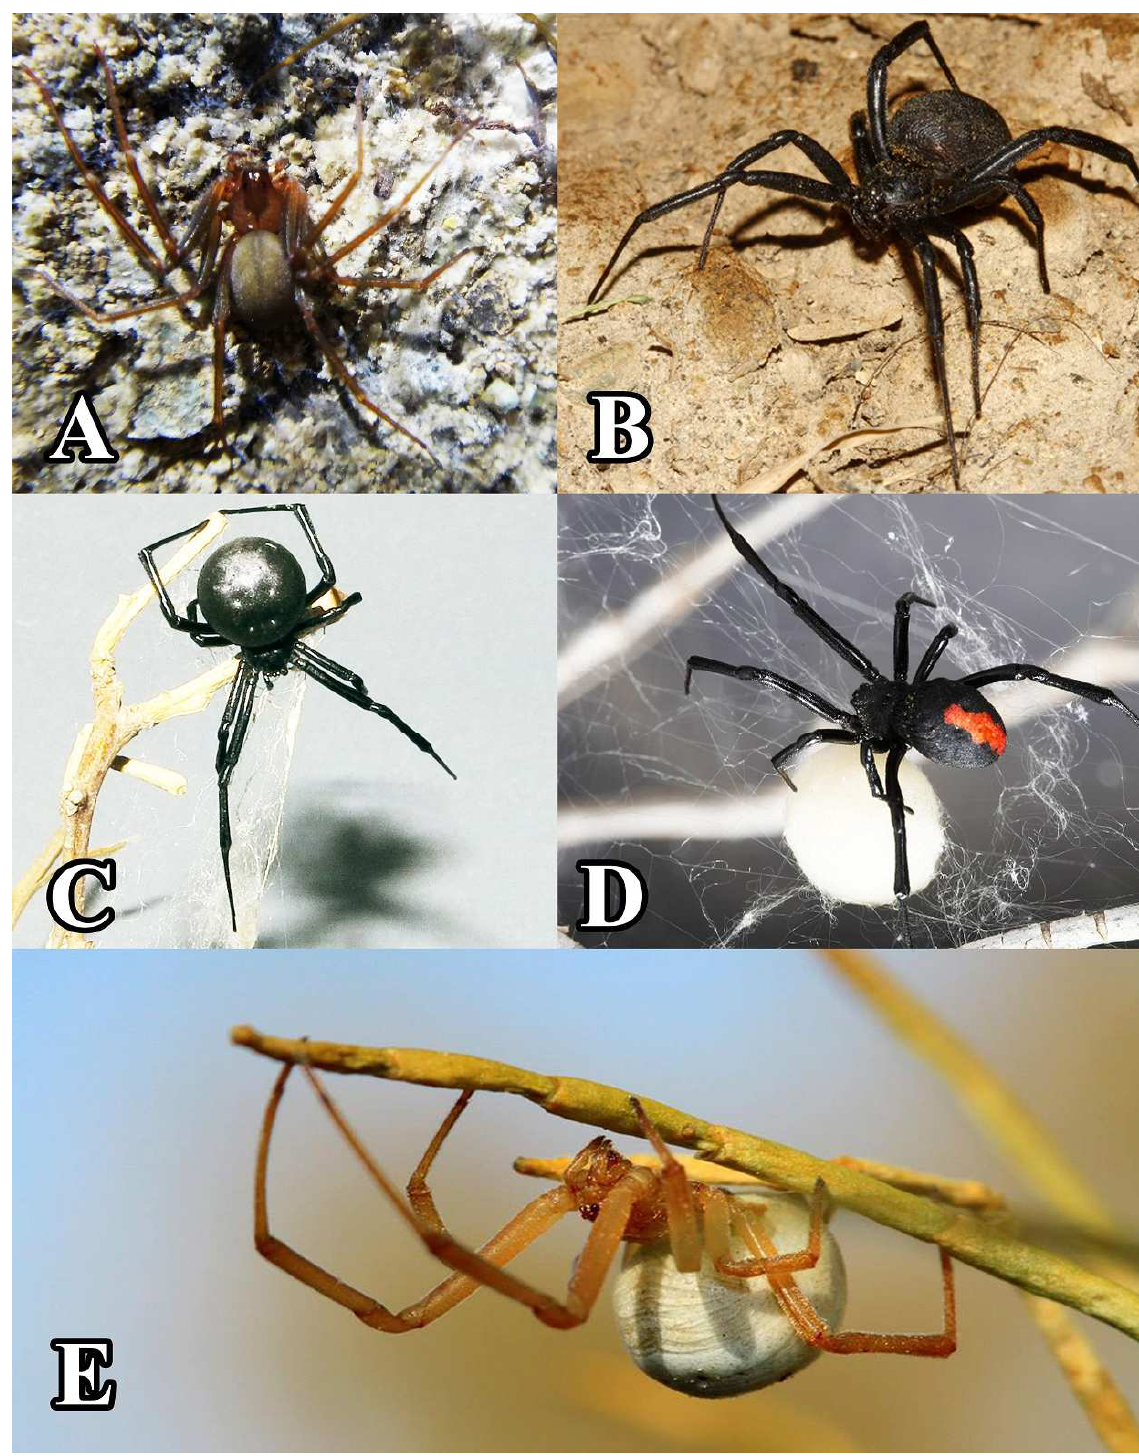
F IGURE 4. Habitus of female specimens of Iranian spiders with significant medical importance. A) Loxosceles rufescens (photo: Zamani); B) Latrodectus dahli (photo: Talebi); C) L . tredecimguttatus (photo: Zamani); D) L . cinctus (photo: Mohajeran); E) L . pallidus (photo: